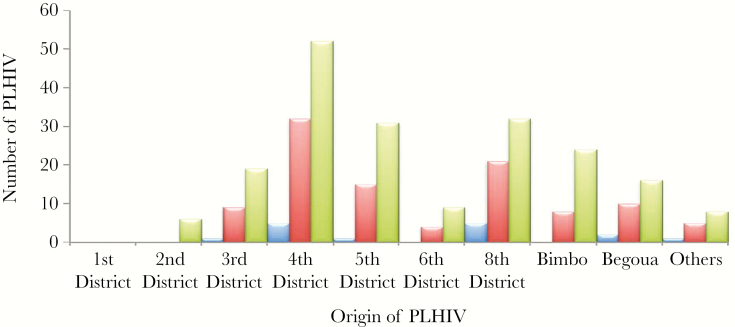
Residence of people living with HIV (PLHIV) patients with IgM–hepatitis E virus (HEV) antibodies (blue) and IgG-HEV antibodies (red) in Bangui and its suburbs. Green columns represent the total number of PLHIV in each district and suburbs. Others: districts or suburbs not determined.